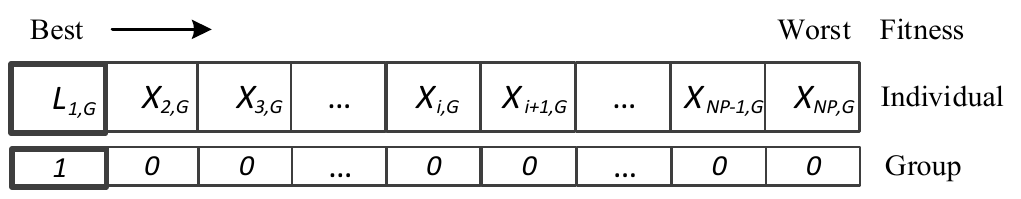
Figure 6. The first group leader with the highest fitness value.